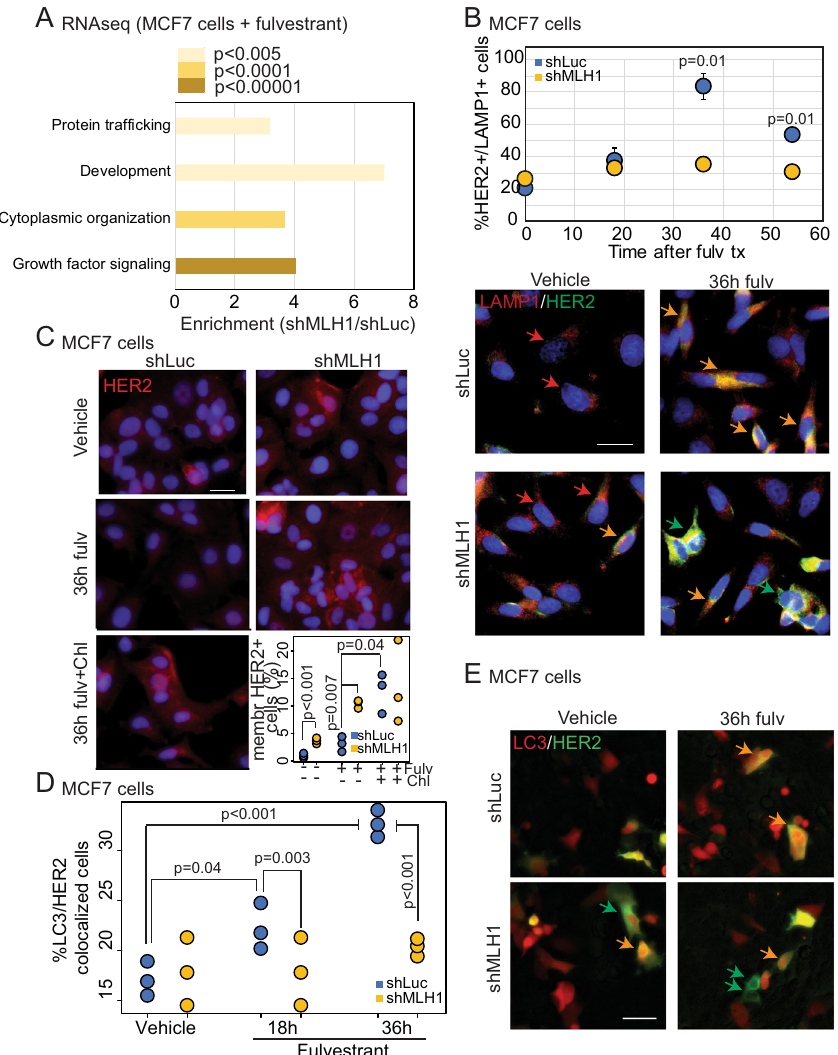
Fig. 3 MLH1 regulates protein traf fi cking of HER2. A Gene set enrichment analysis of RNAseq data comparing isogenic sh Luc and sh MLH1 MCF7 cells after treatment with fulvestrant for 4 days. P values were generated using DESeq2 R package and adjusted for multiple comparison using Benjamini – Hochberg. Comparable RPPA data analysis in Fig. S4A. Raw read counts available as supplementary data. B Co-immuno fl uorescence for HER2 and lysosomal marker, LAMP1 (orange arrows) at baseline and after 18, 36, and 54 h of fulvestrant treatment. Green arrows indicate HER2 that is not colocalized with LAMP1, and red arrows indicate LAMP1 positivity alone. Validation in T47D cells in Fig. S4B. C Immuno fl uorescence staining for HER2 in MCF7 sh Luc and sh MLH1 cells treated with vehicle and 36 h of fulvestrant alone or a combination of fulvestrant and chloroquine, an autophagy inhibitor. For sh Luc vs. sh MLH1 vehicle, p = 0.0006. Validation in T47D cells in Fig. S4C. Quanti fi cation ( D ) and representative photomicrographs ( E ) from 36 h of live cell tracking of colocalization of HER2 and LC3 (orange arrows), a marker of autophagosomes, in MCF7 sh Luc and sh MLH1 cells treated with vehicle or fulvestrant. Green arrows indicate HER2 + LC3 − cells. Cells were tracked after administration of fulvestrant. All quanti fi cation is of three independent biological replicates conducted through ImageJ and is represented as strip charts. Two-sided Student ’ s t test determined all p values. For sh Luc vehicle vs. 36-h fulvestrant treatment, p = 0.0003 and for sh Luc vs. sh MLH1 at 36-h fulvestrant treatment, p = 0.0005. Scale bars represent 50 µ . Source data for all fi gures available with